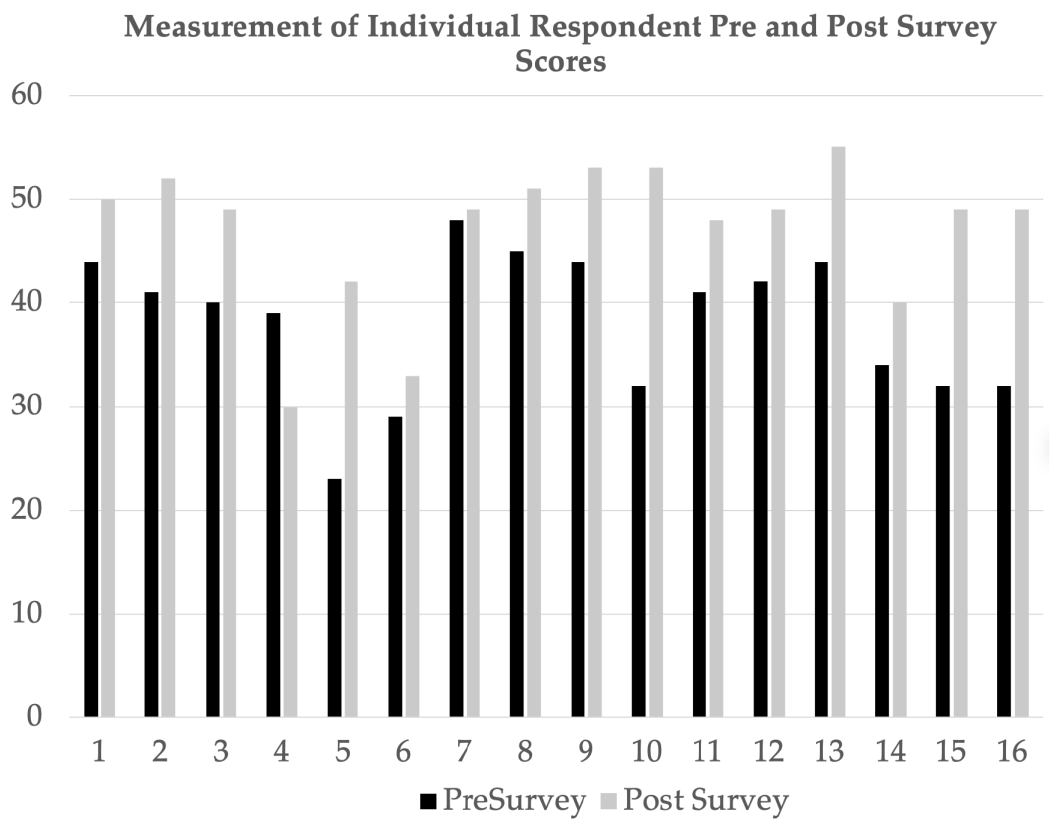
Figure 3. Measurement of individual participant